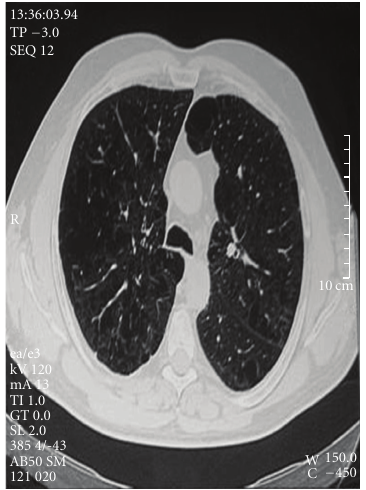
Figure 1: Two years before his admission he was presented with dyspnea on exception, and on CT imaging emphysema was the main